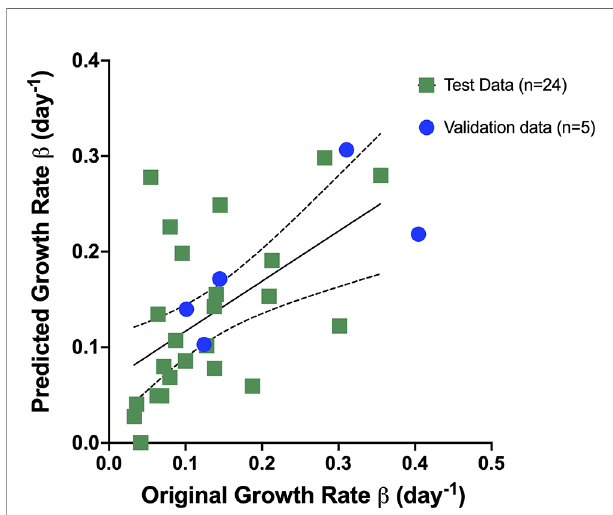
FIGURE 8 | Representative data from the k-fold cross-validation of the multivariate linear regression model given by the Equation: Growth rate b = b 0 + b 1 ∗ pretreatmentvolumeb 2 ∗ StO 2 ( D 7 − D 10)+ b 3 ∗ StO 2 ( D 10 − D 14). The training data set is represented by green squares (n = 24), the representative regression line in black, and the validation data set is represented by blue circles (n =